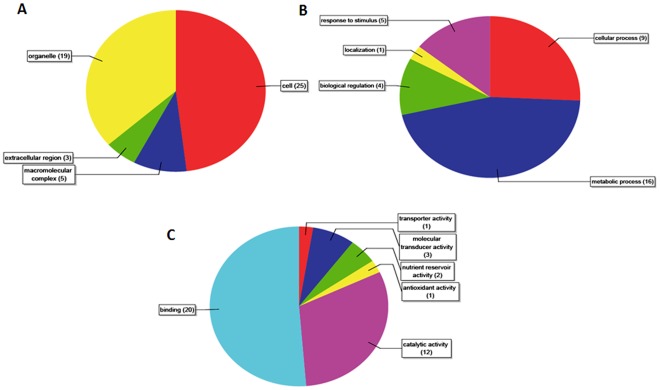
Pie graphs illustrating the distribution of target sequences based on their annotation in KEGG.(A) Based on their annotated molecular function (MF), the genes were classified as “transporter activity”, “molecular transducer activity”, “nutrient reservoir activity”, or “catalytic activity”. (B) Based on their annotated involvement in various biological processes (BP), genes were classified as “response to stimulus”, “localization”, “biological regulation”, “cellular process”, and “metabolic process”. (C) Based on their annotated localization in various cellular components (CC), genes were classified as “cell”, “organelle”, and “macromolecular complex”.